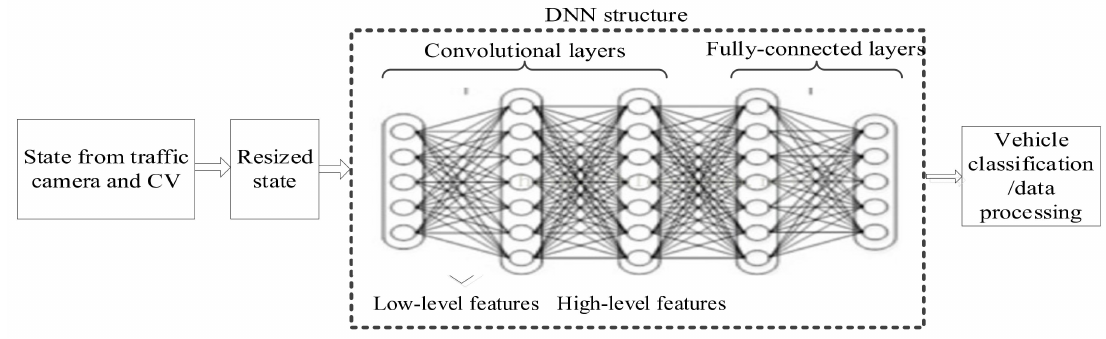
Figure 7. Structure of deep neuron